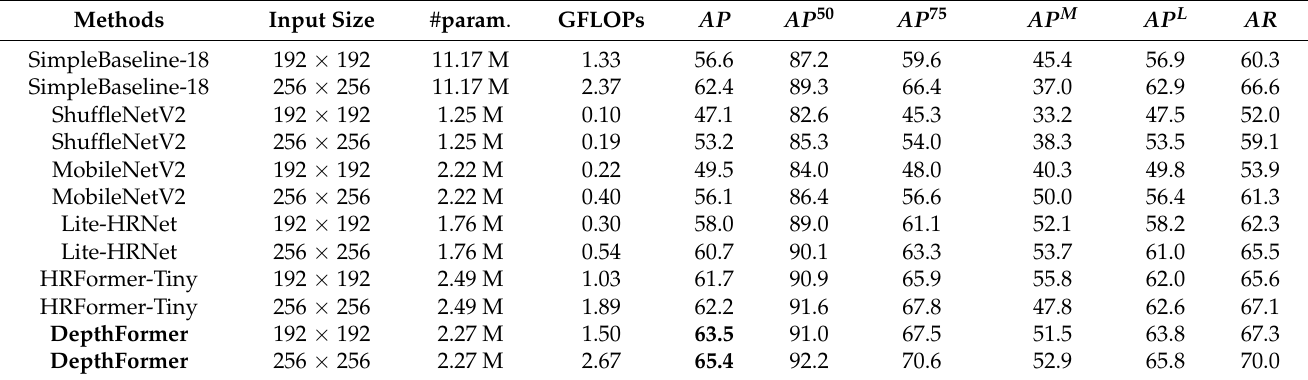
Table 2. Comparison on the AP-10K val set. The volume of parameters and FLOPs for the animal pose estimation network are measured without animal detection and the keypoint head.